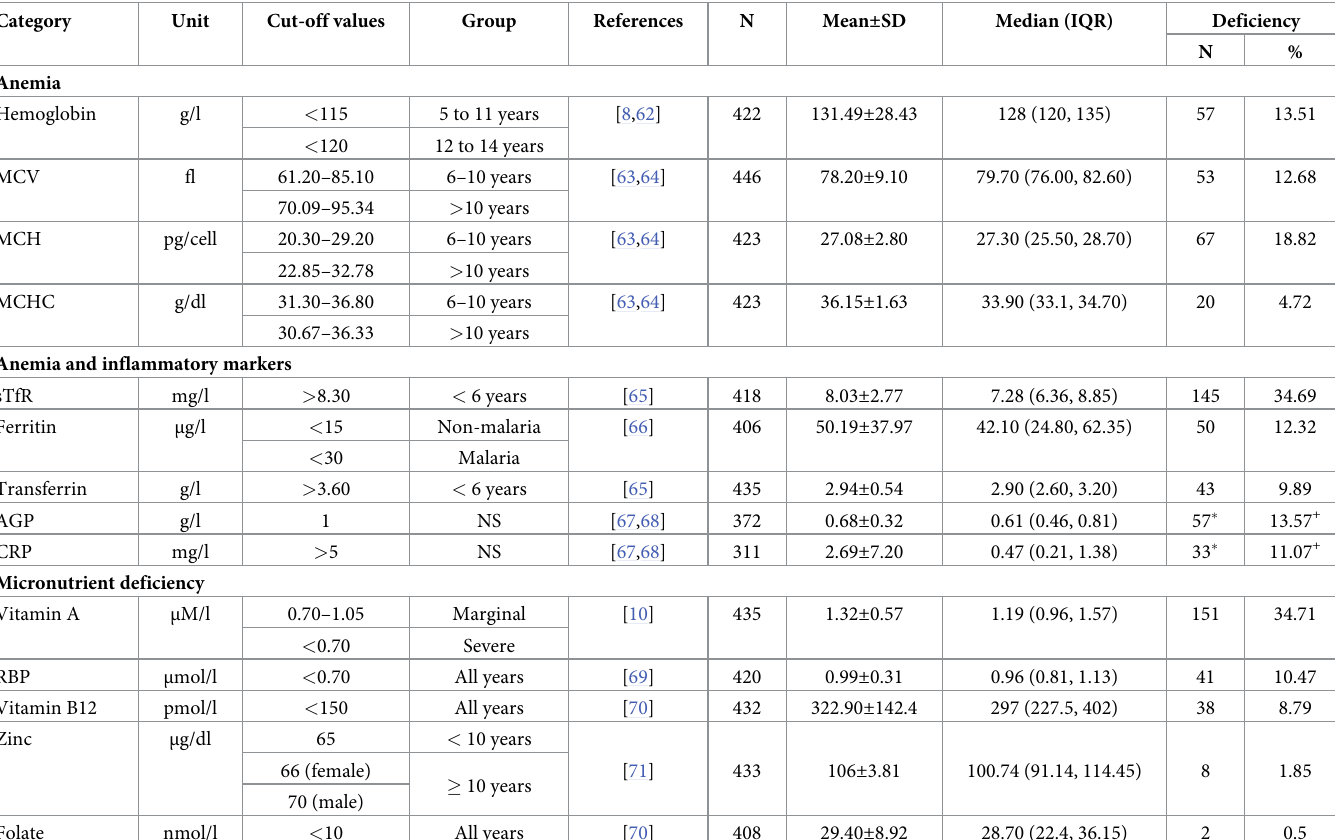
Table 2. Levels of hemoglobin, complete blood count, serum micronutrients, anemia and inflammatory markers among schoolchildren in Kikwawila and Kiberege wards, Tanzania.